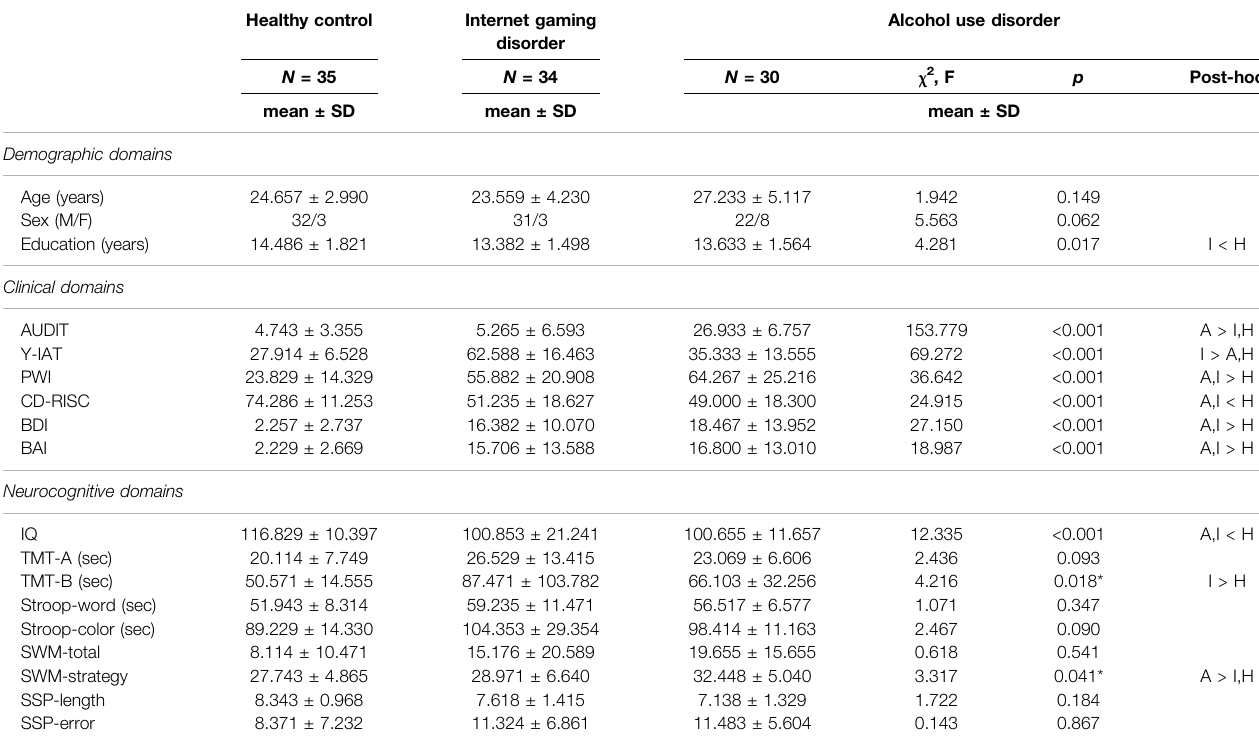
TABLE 1 | Demographic, clinical and neurocognitive variables in the alcohol use disorder, Internet gaming disorder and healthy control groups. Healthy control Internet gaming Alcohol use disorder